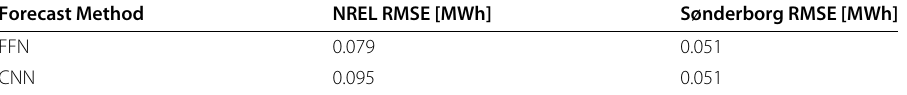
Table 3 24h forecast results for the NREL in Golden, Colorado and the Sønderborg DHN Forecast